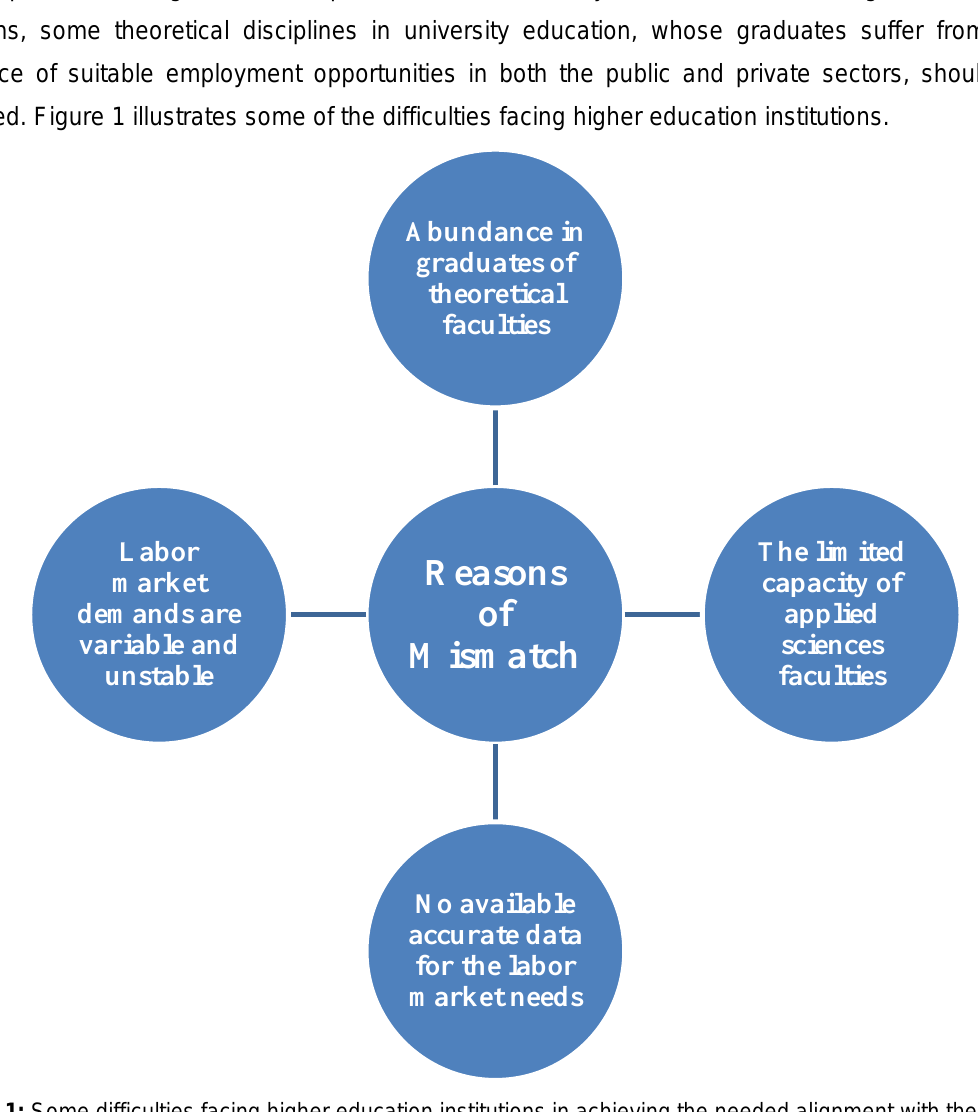
Figure 1: Some difficulties facing higher education institutions in achieving the needed alignment with the labor market. Source: Own elaboration based on the Survey of IDSC,